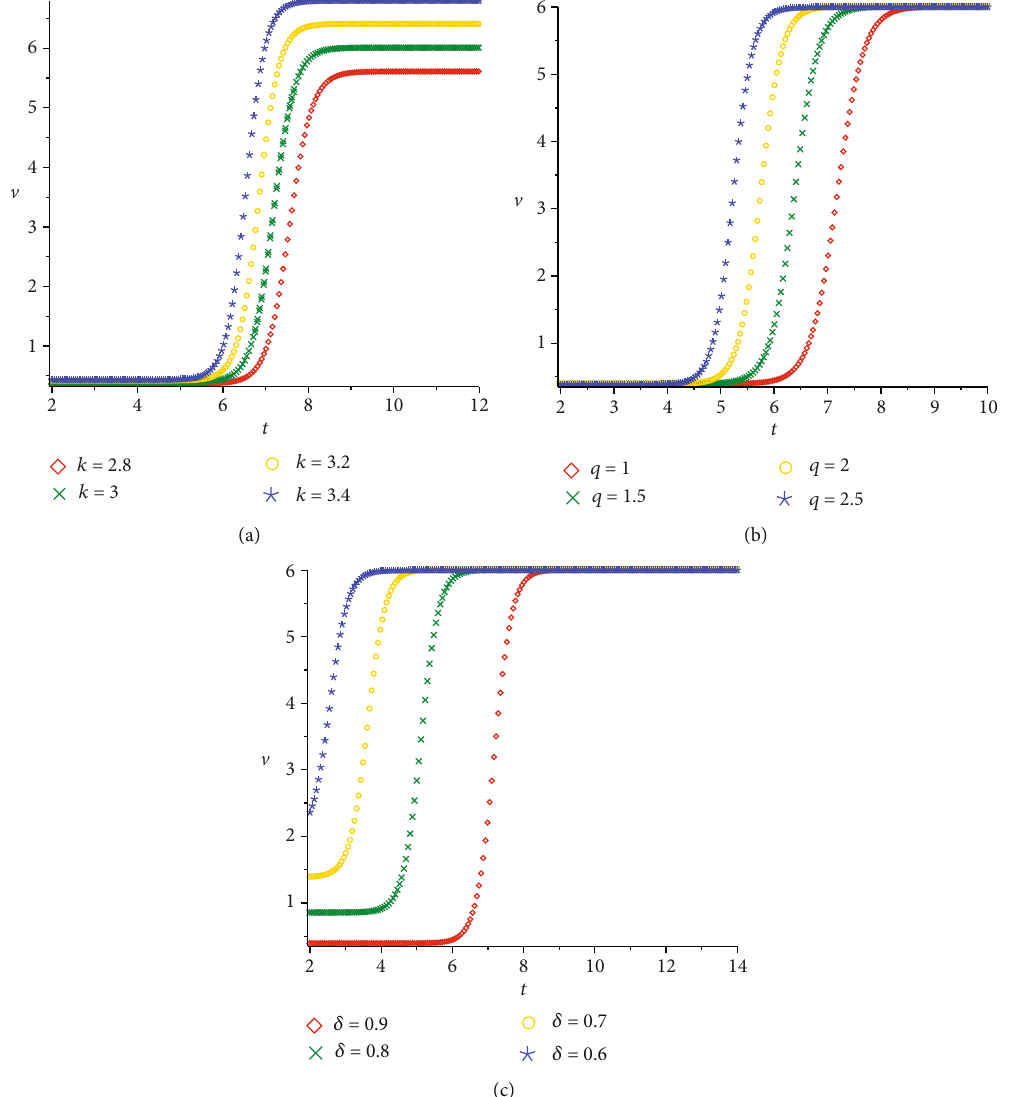
Figure 5: Single shock wave for l = 1 : (a) q = 1, δ = 0 : 9 , (b) k = 3, δ = 0 : 9 , K = 3 , q = 1 , and (c) q = 1, k = 3 at x = 40 1